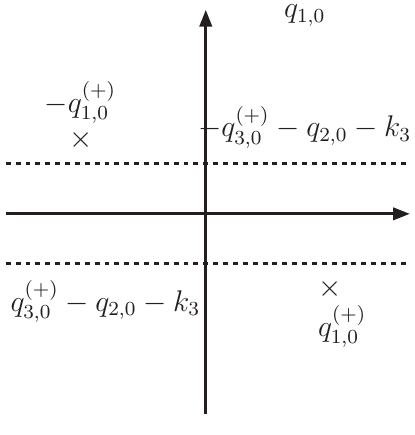
Figure 1 . Pole structure of a rational function of two